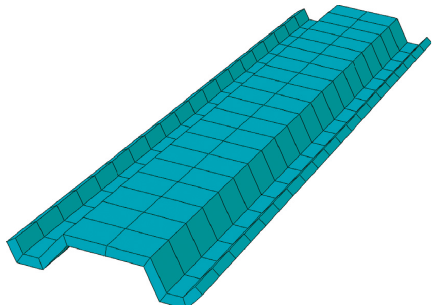
Figure 8: Mesh diagram of the corrugated steel plate.